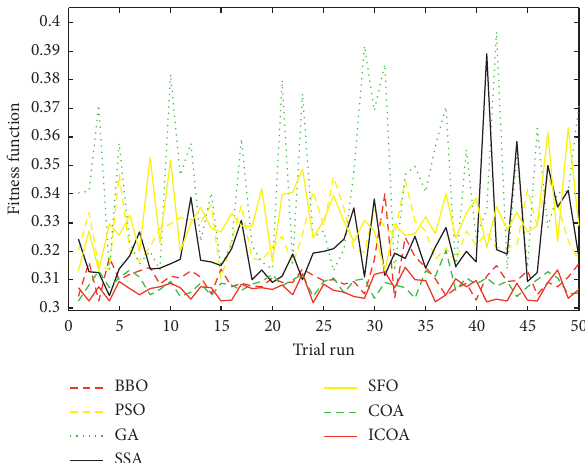
Figure 10: The fitness values of seven methods in 50 trial times for the first case.